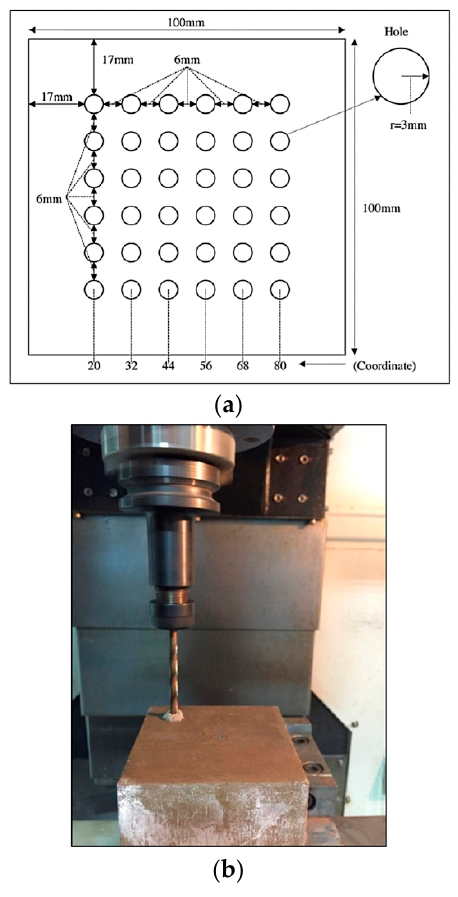
Figure 3. ( a ) Diagram of designated drilled holes on the workpiece and ( b ) drilling operation on geopolymer samples.